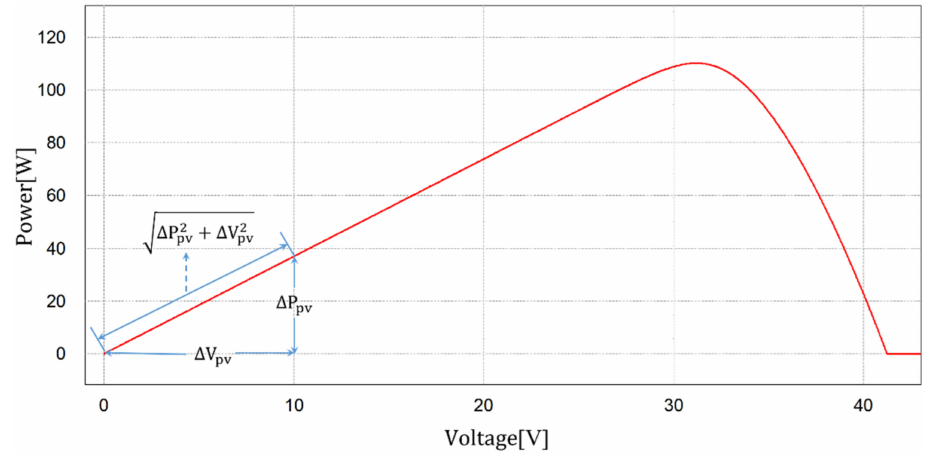
Figure 10. Changing voltage and power in the P-V curve.